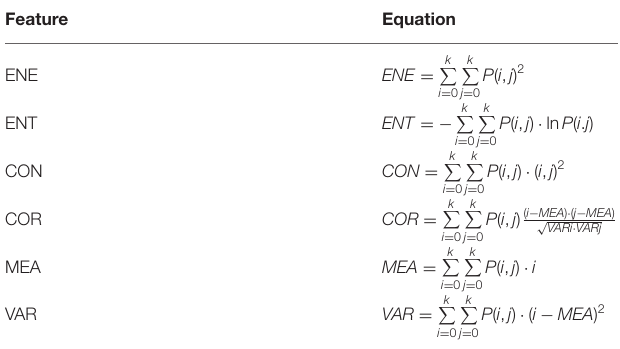
TABLE 1 | The calculation equations for the characteristics of the GLCM. Feature